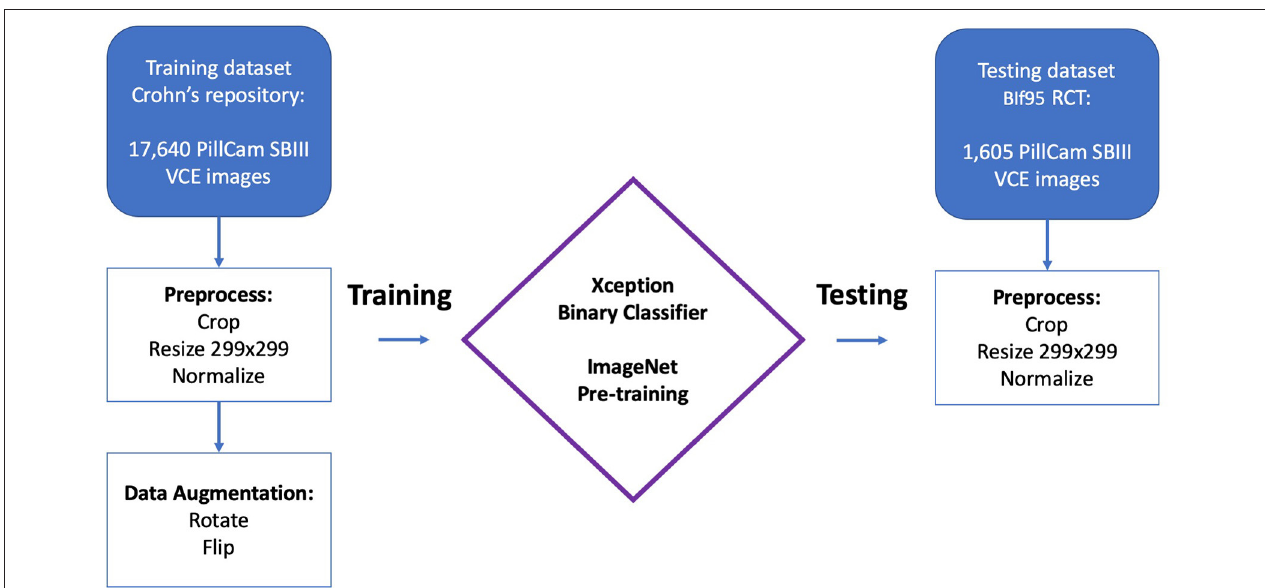
FIGURE 1 | Schematic representation of an artificial neural network (ANN). The network is composed by many linear regression units, termed neurons. These units are structured in sequential layers. Outputs of neurons from the previous layer are the inputs of the neurons in the next layer. The connection between the layers are termed weights, which are similar to the weights of a linear regression unit. Data, such as an image, is propagated through the network, and a final prediction is outputted. An optimized network will produce a desired prediction for each data entry.